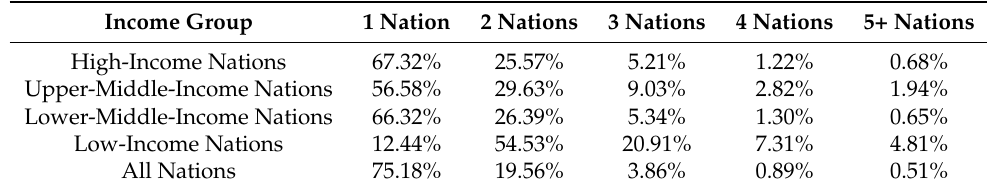
Table 4. Distribution of the number of collaborating nations per paper.